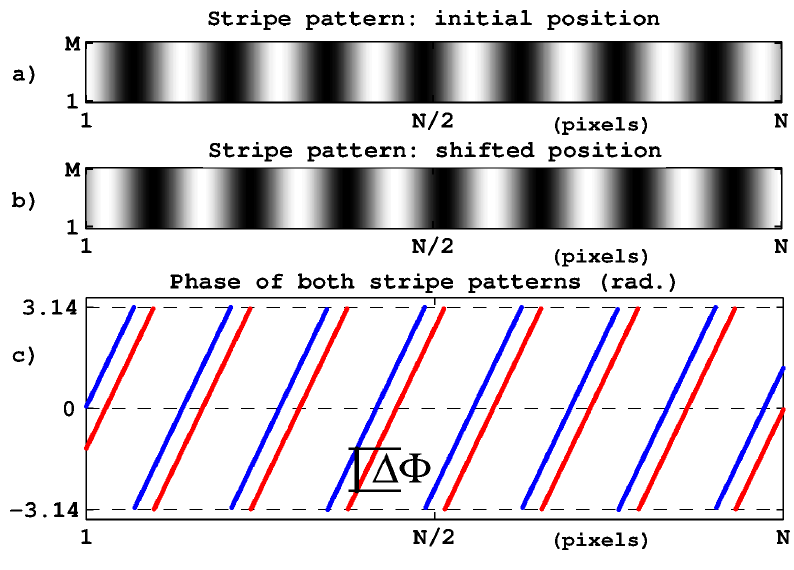
Figure 1. Correspondence between lateral position and phase of a sinusoidal pattern. ( a ) stripe set before displacement; ( b ) after displacement; ( c ) wrapped phase for both